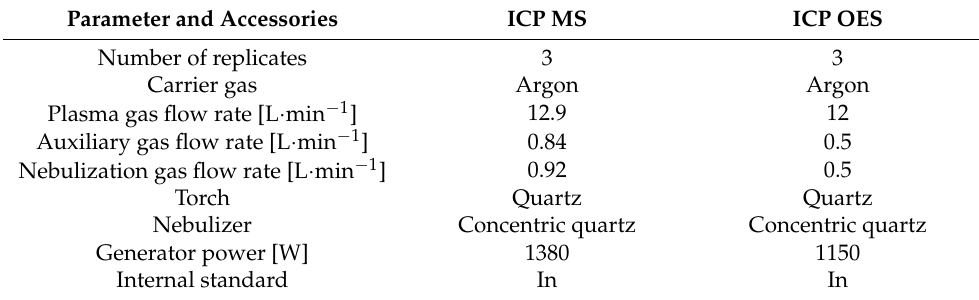
Table 3. ICP-MS (Thermo Electron Corporation, X SERIES, UK) and ICP-OES (Thermo Scientific, ICAP 7000 series, MA, USA) parameters and measurement